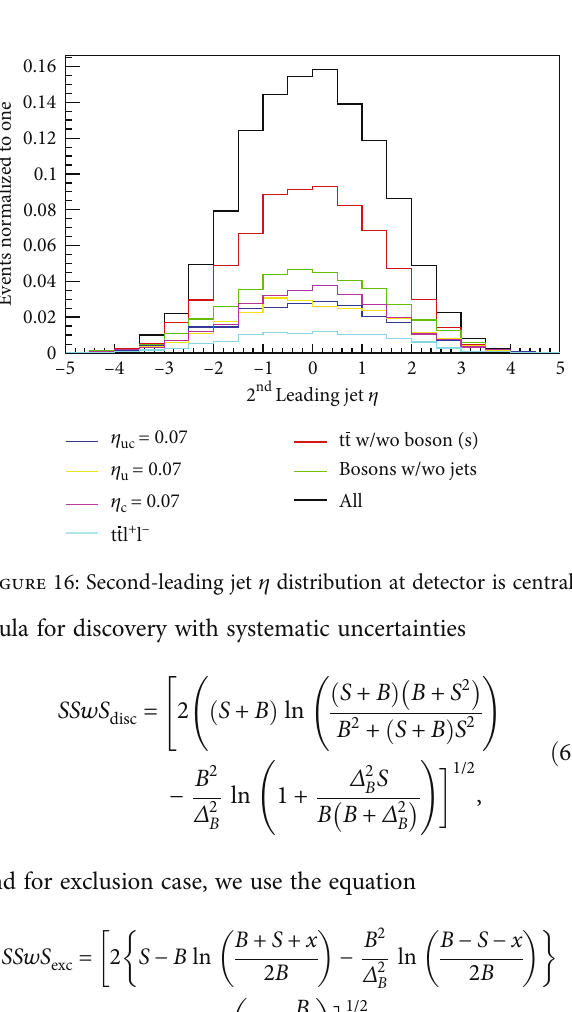
Figure 14: The overall behavior of the secondary jets in the backgrounds is highly forward, in contrast to the second jets in the